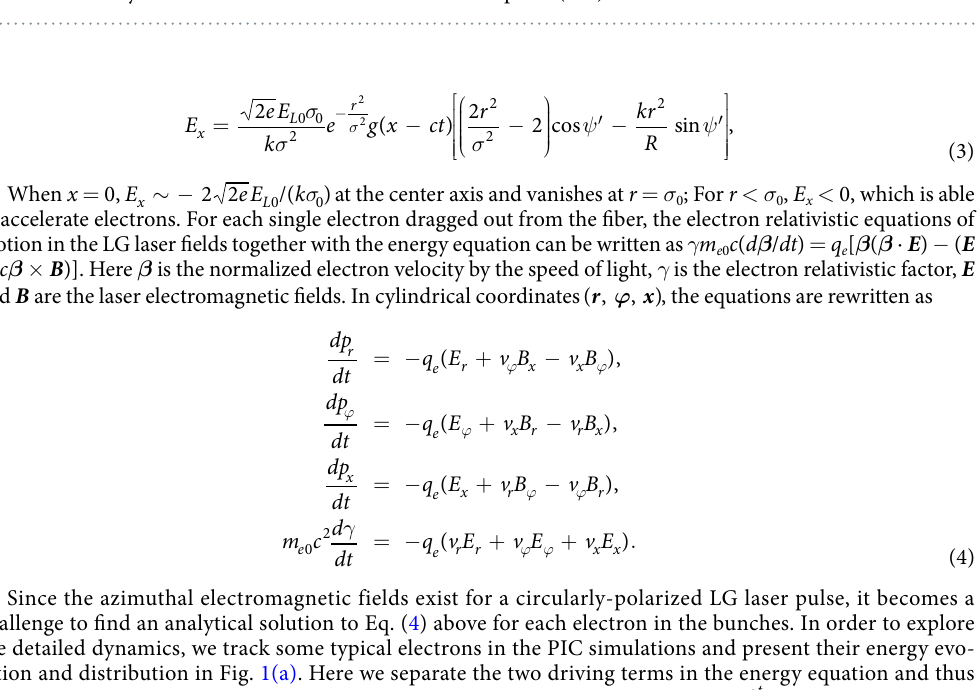
Figure 1. Density evolution of the attosecond electron bunches ( a – c ). The panels ( d – f ) show the corresponding transverse density distribution of a bunch as marked in the panel ( a – c